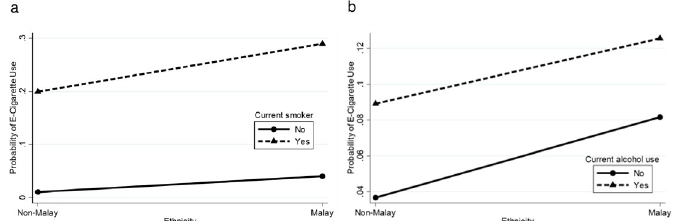
Fig 3. Probability of current e-cigarette use. (a) Ethnicity-current smoker: non-Malay (no = 1.1%, yes = 20.0%), Malay (no = 4.0%, yes = 29.0%). (b) Ethnicity-alcohol use: non-Malay (no = 3.7%, yes = 8.9%), Malay (no = 8.2%, yes = 12.6%).